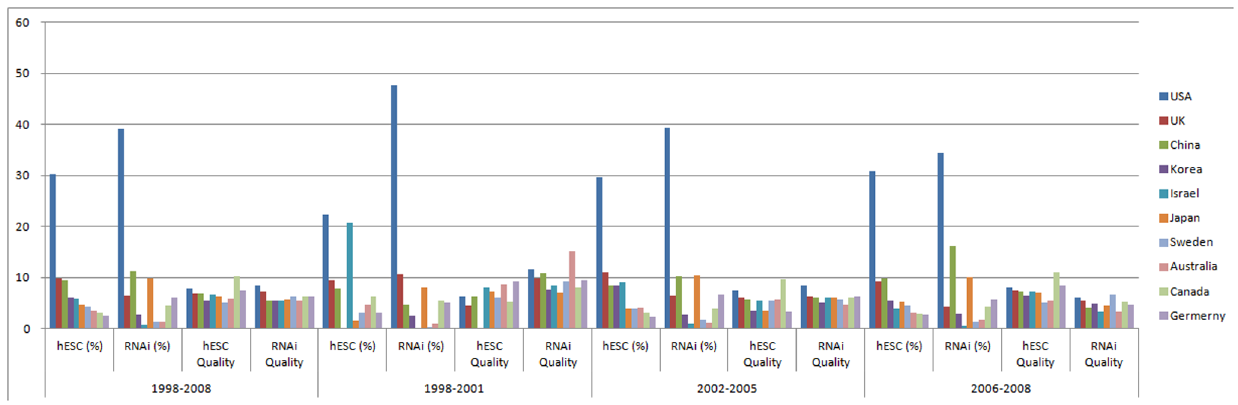
Figure 1. Contribution to hESC Research. This figure contains top 10 countries in terms of percentage in hESC research. Y axis indicates percentage (%).